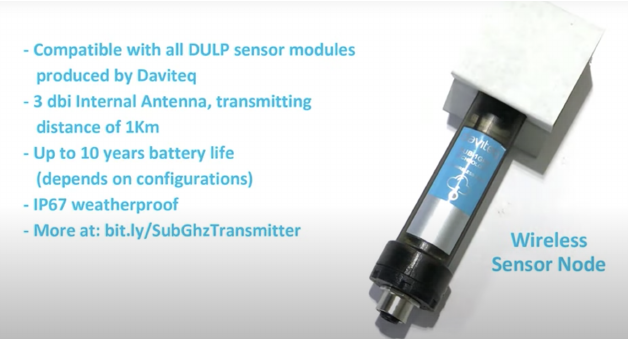
Figure 1. Wireless sensor node device [7].